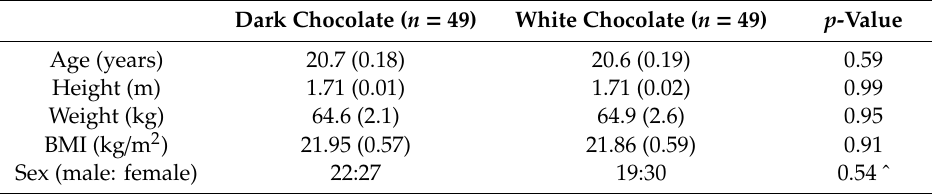
Table 1. Demographic information by treatment